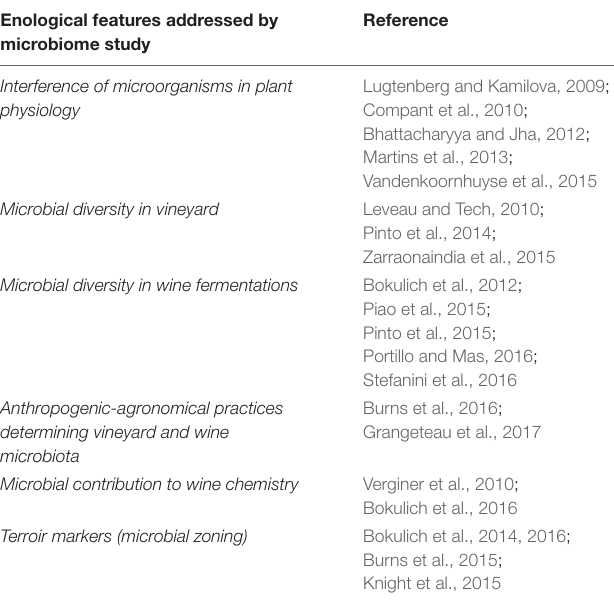
TABLE 1 | Research and industrial hallmarks of viticulture and enology led by NGS approaches. Enological features addressed by microbiome